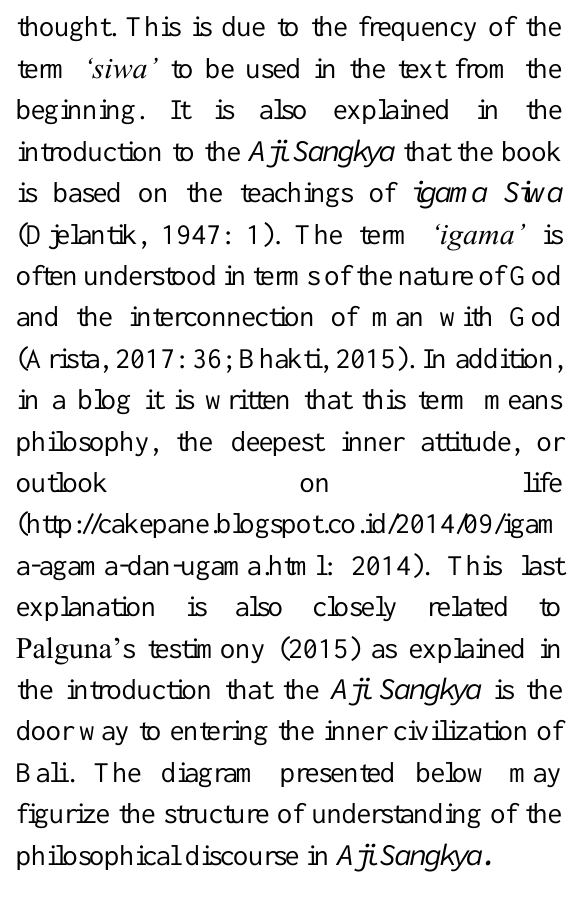
Figure 1. Structure of the evolution of the philosophical discourse in the Aji